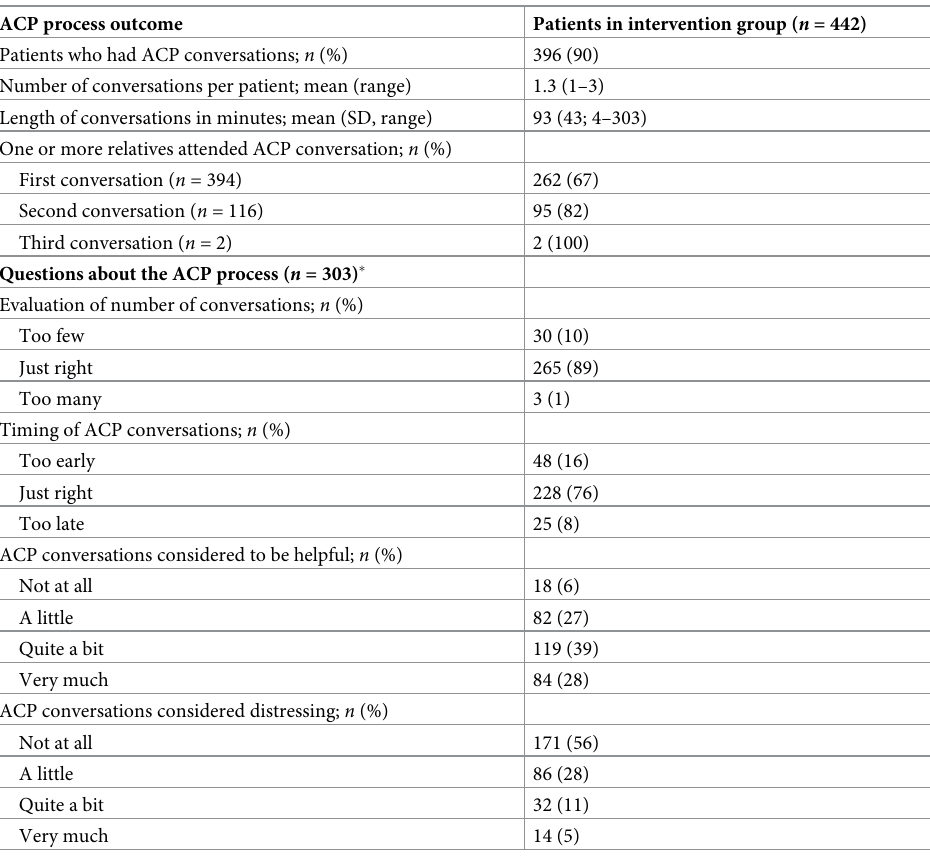
Table 4. ACP process and its evaluation by patients. ACP process